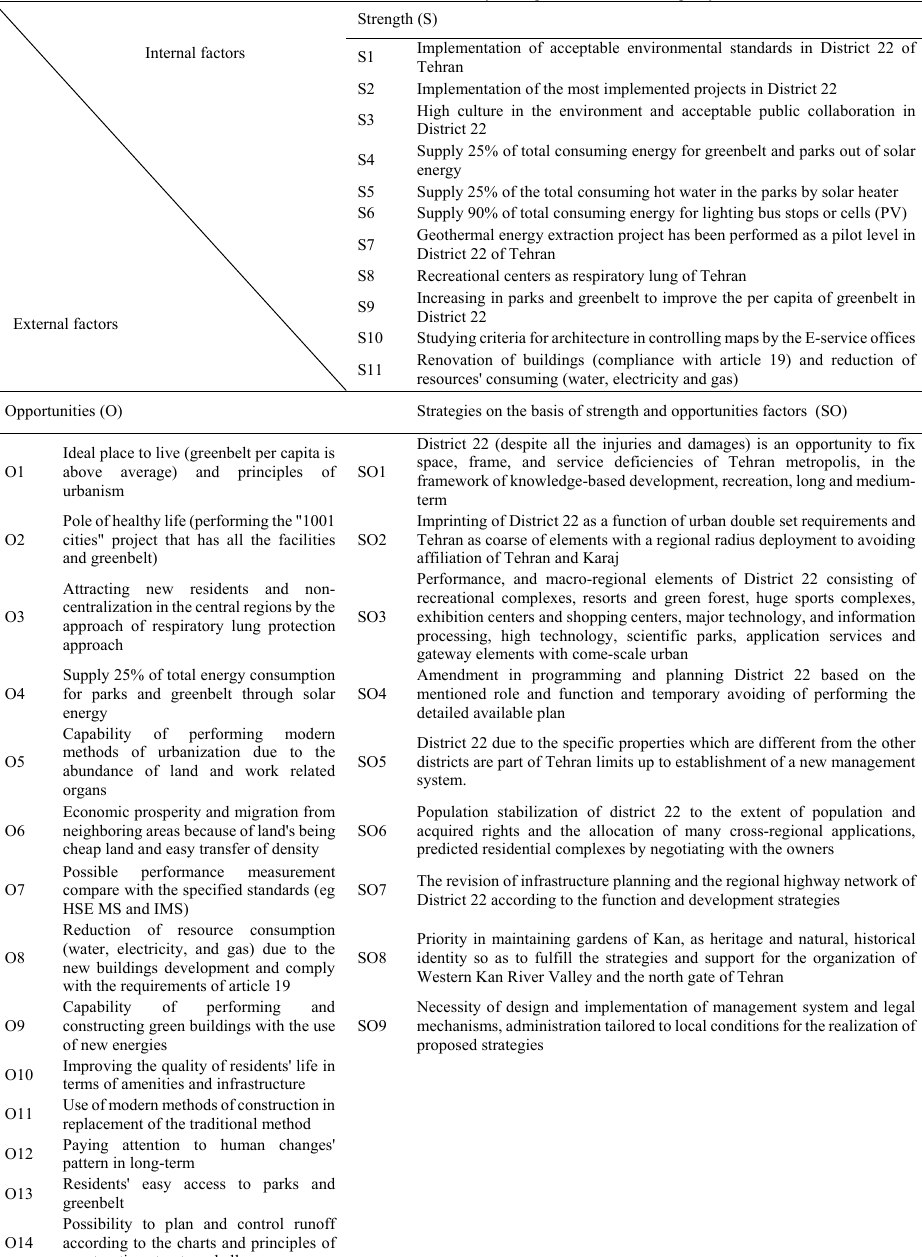
Table 6: SWOT matrix: Derivation of the key strategies in Tehran Municipality District 22